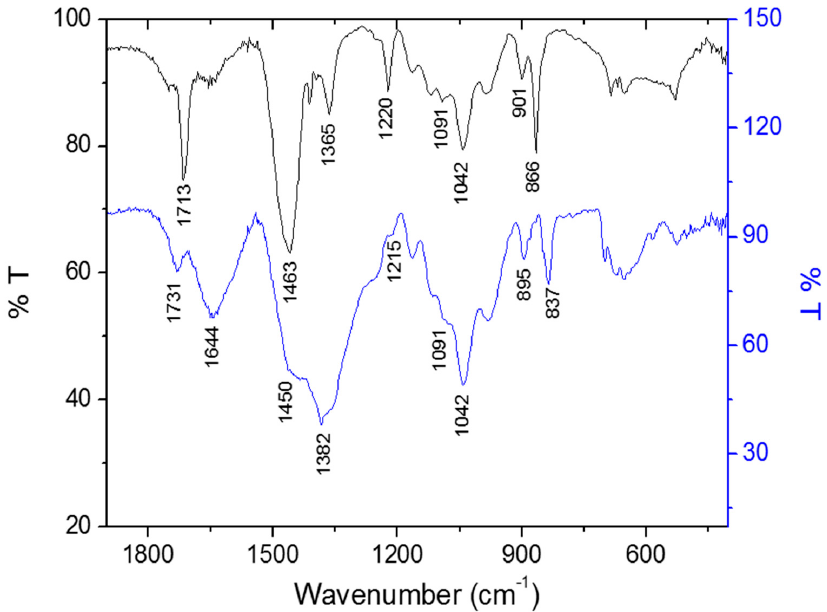
Figure 8. Overlapping infrared spectra of xylan (black) and nanoxylan (blue) in the 1900 to 400 cm − 1 Figure8. Overlappinginfraredspectraofxylan(black)andnanoxylan(blue)inthe1900to400cm − 1 regions. regions.